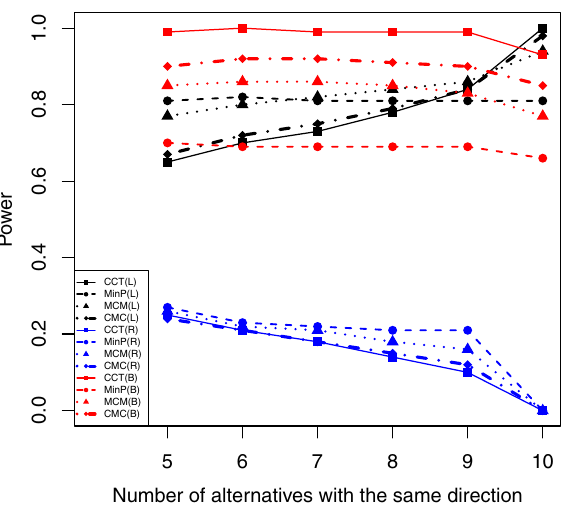
Figure 3. Empirical power when there are 10 out of 20 p -values are significant with model = “SiG”, d = 0.5 , and µ = 2 .